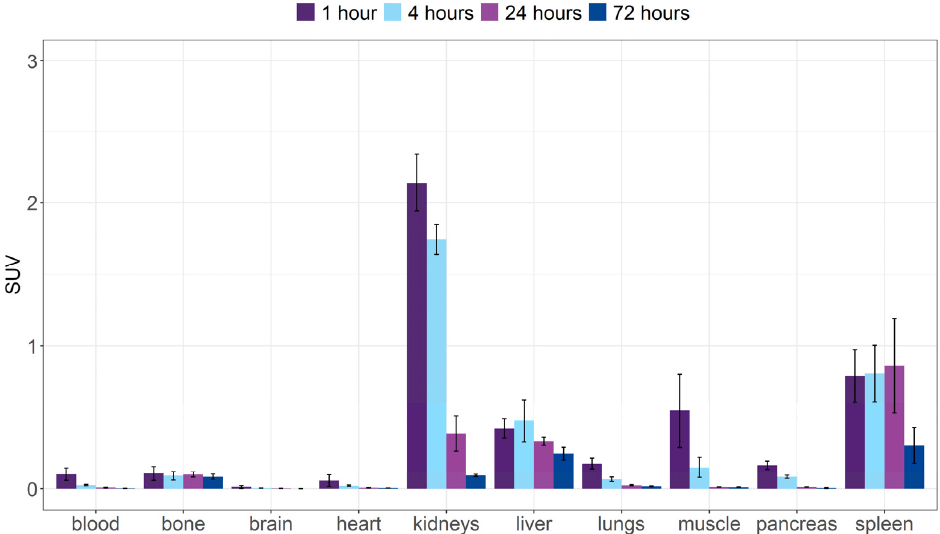
Figure 5. Ex vivo biodistribution over time expressed as standard uptake value of [ 153 Sm]Sm-DOTA- TATE in healthy mice. Values represent mean ± standard deviation ( n = 3–4).